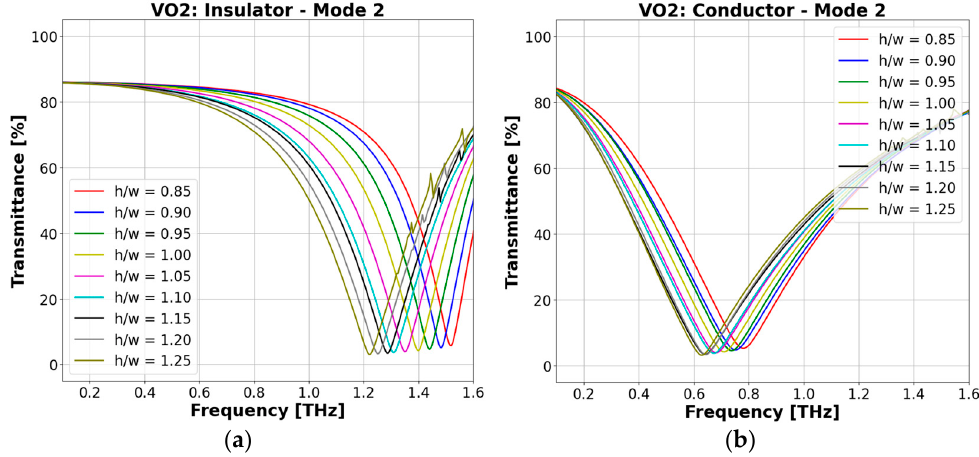
Figure 4. Transmittance of the double-split rectangular metamaterial in mode 2 with electric field polarization perpendicular to the VO 2 thin film line according to the aspect ratio. ( a ) VO 2 in the insulator state and ( b ) VO 2 in the conductor state.